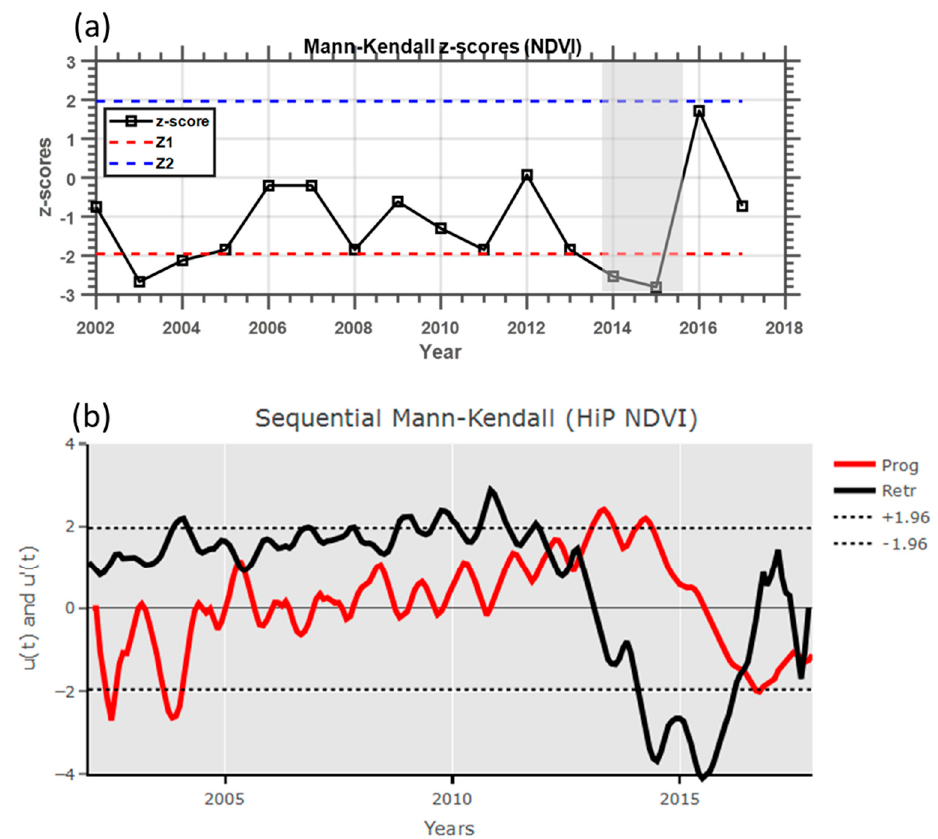
Figure 9. ( a ) The inter-annual variation of Mann–Kendall z -scores ( α = 0.05, Z 1 = –1.96, Z 2 = 1.96) for the HiP from 2002 to 2017. ( b ) Sequential statistics values of progressive (Prog) u ( t ) (solid red line) and retrograde u (cid:48) ( t ) (black solid line) obtained by Sequential Mann-Kendall (SQ-MK) test for HiP monthly mean NDVI data for the period from 2002 to 2017.